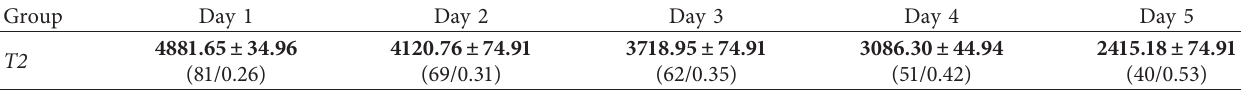
The number of motile sperm per ejaculate is shown in bold; the number of doses with 60-million motile sperm cells for intracervical insemination/volume (mL) is in brackets. SM-EY: skim milk-egg yolk; T0: SM-EY extender without the protein; T1: SM-EY extender +12 μ g protein/100mL extender; T2: SM-EY extender +24 μ g protein/100mL